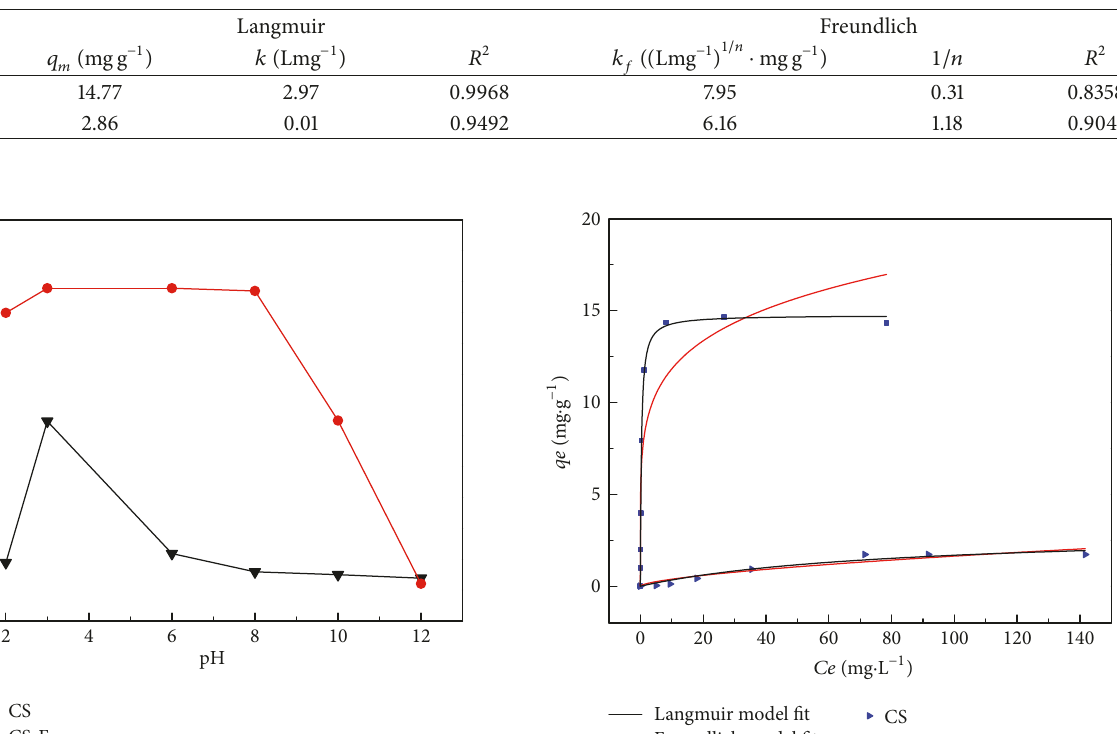
Table 2: Regression parameters of isotherms of As (V).